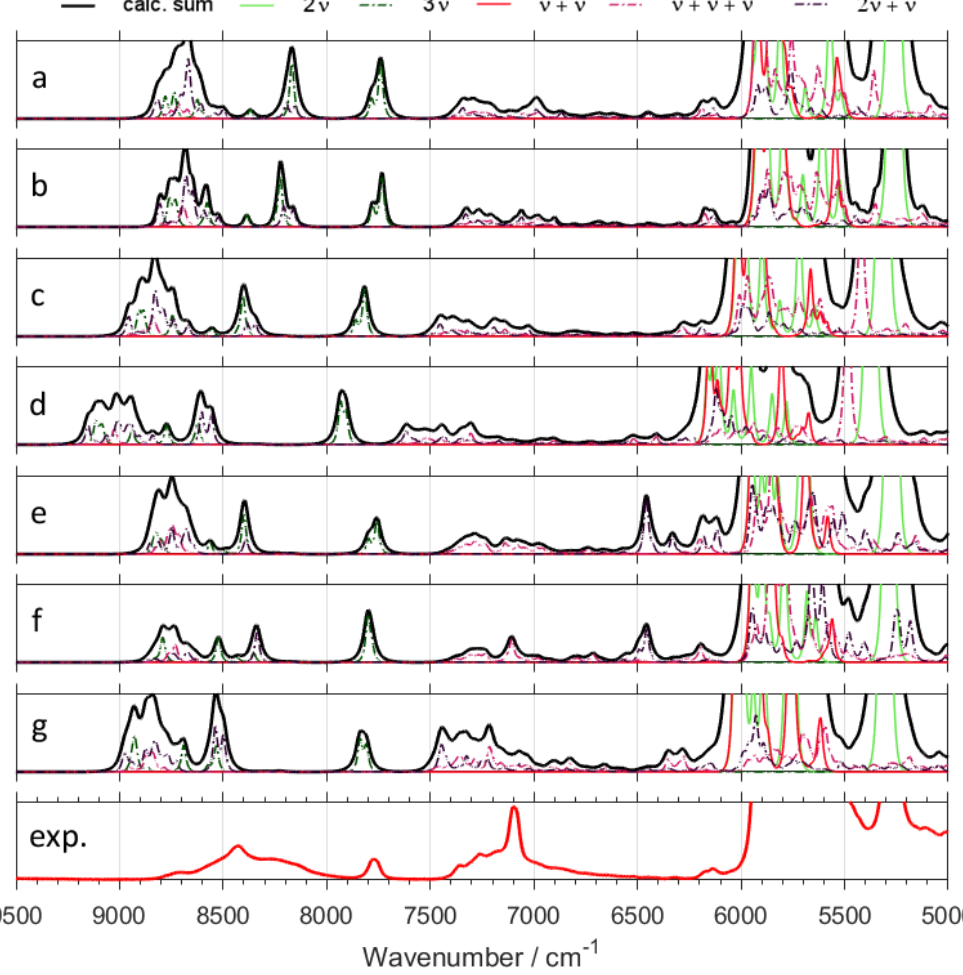
Figure 4. Contributions from minor bands in NIR spectra of CH 3 CH 2 OD calculated with GVPT2 method at different levels of electronic theory; ( a ) B3LYP-GD3BJ/6-31G(d,p); ( b ) B3LYP-GD3BJ/6-31G(d,p)//CPCM; ( c ) B2PLYP-GD3BJ/6-31G(d,p)//CPCM; ( d ) MP2/6-31G(d,p)//CPCM; ( e ) B3LYP-GD3BJ/SNST//CPCM; ( f ) B2PLYP-GD3BJ/def2-TZVP//CPCM; ( g ) MP2/aug-cc-pVTZ//CPCM; ( exp. ) Experimental spectrum of CH 3 CH 2 OD in CCl 4 (0.1 M).